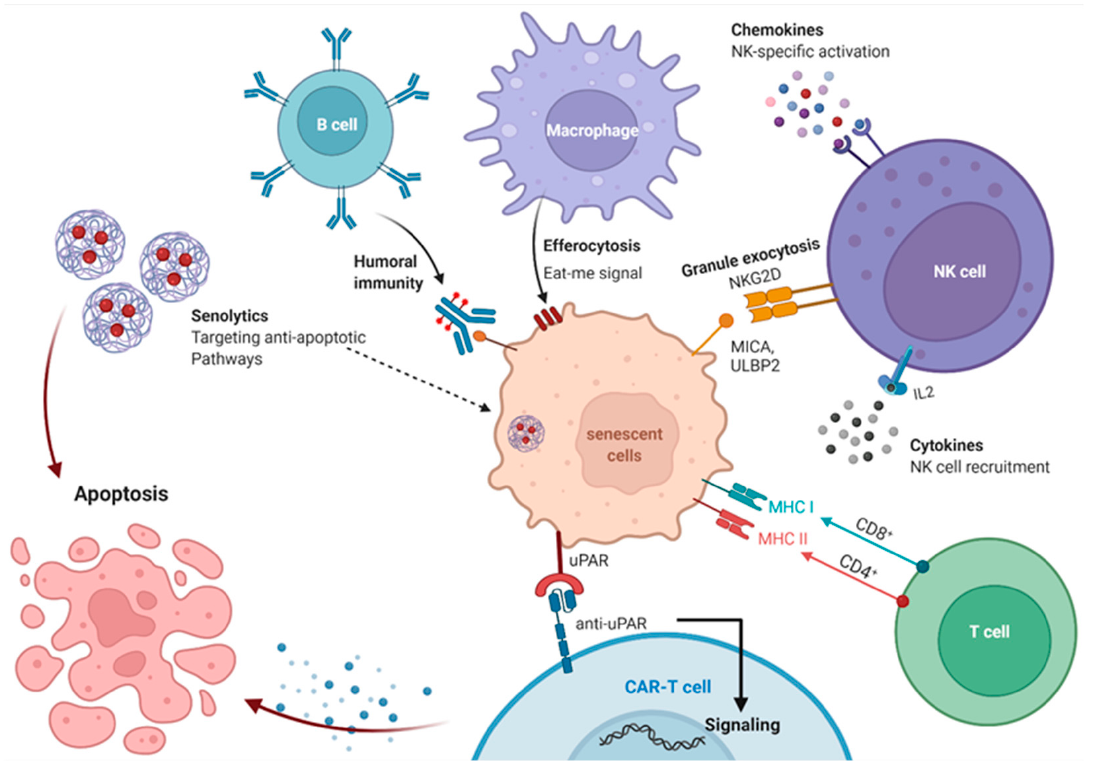
Figure 4. Clearance of senescent cells through immune system activation or apoptosis induction via senolytics. Distinctive ligands generated by senescent cells, including MICA, ULBP2, MHC I, and MHC II recognized by immune cells, such as NK cells, T cells, macrophages, and CAR-T cells. B cells eliminate senescent cells through a humoral antibody immunity.